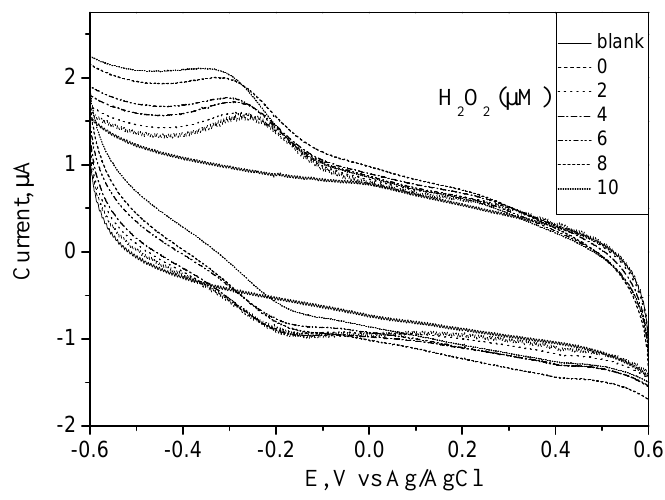
Figure 4. Influence of concentration of H